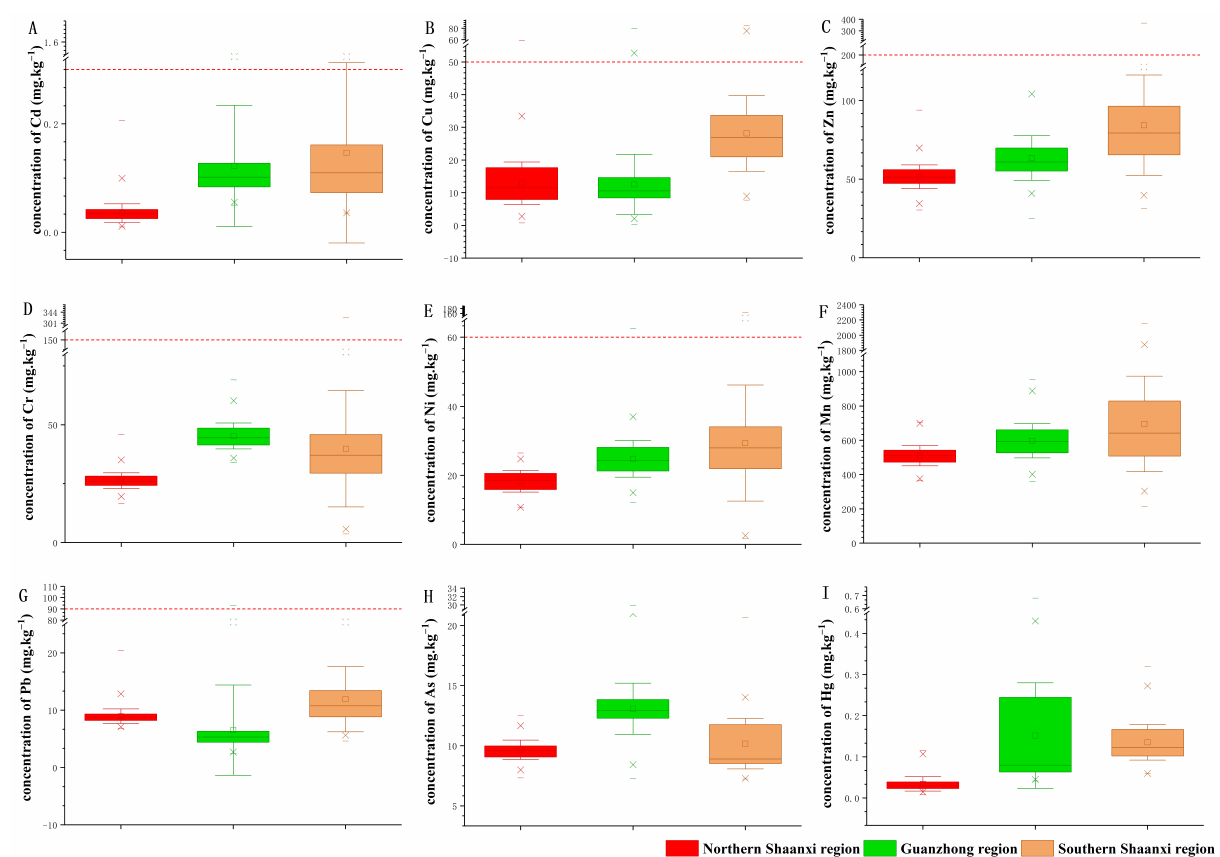
Figure 3. The concentrations (means ± standard deviation) of Cd ( A ), Cu ( B ), Zn ( C ), Cr ( D ), Ni ( E ), Mn ( F ), Pb ( G ), As ( H ), and Hg ( I ) in soil samples. The red lines indicate the risk screening concentration of the National Standard (GB 15618-2018) of the People’s Republic of